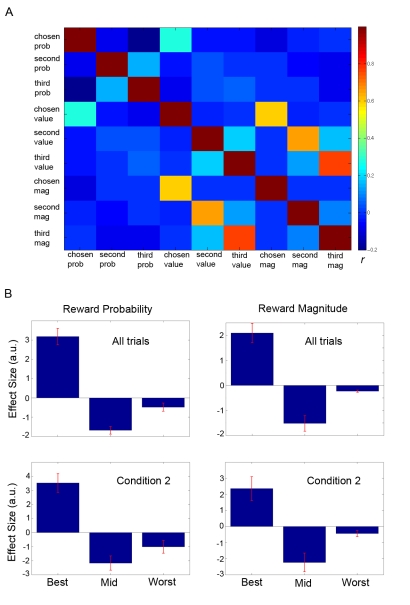
Cross-correlation matrix and behavioral regression coefficients.(A) Group cross-correlation matrix depicting mean correlation (r) across participants between reward probabilities, expected values, and reward magnitudes of chosen, next best, and worst options. (B) Mean regression coefficients (i.e., parameter estimates) related to the reward probabilities (left column) and reward magnitudes (right column) of the options with the highest, middle, and lowest expected value derived from a logistic regression on optimal choices (i.e., choices of the option with the highest expected value). Error bars represent standard error of the mean (s.e.m.).